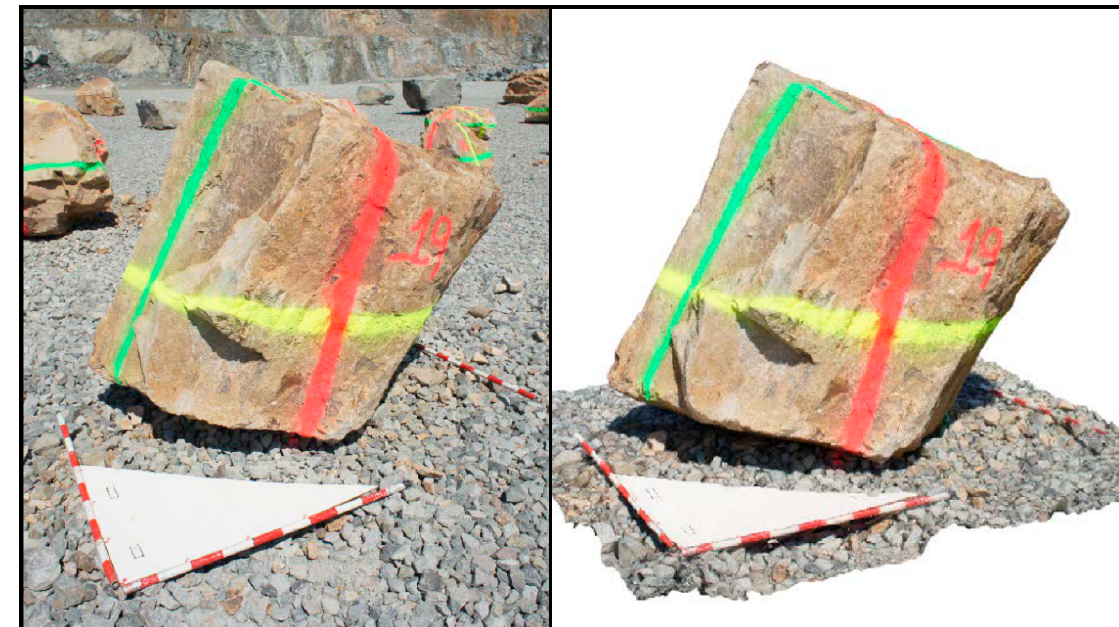
Figure 4. Picture of a block with rules to be scaled (left) and the 3D model obtained (right).